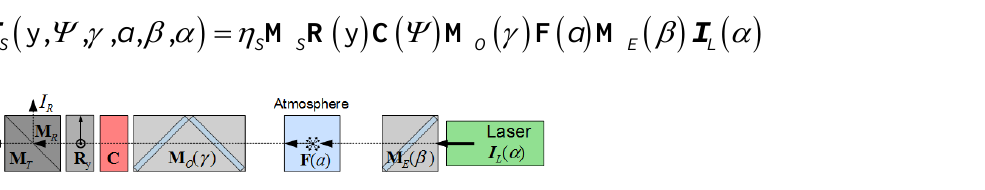
The whole lidar system shown in Fig. 2 is then described by Eq. (48) with rotation angles α, β, γ, and Ψ around the optical